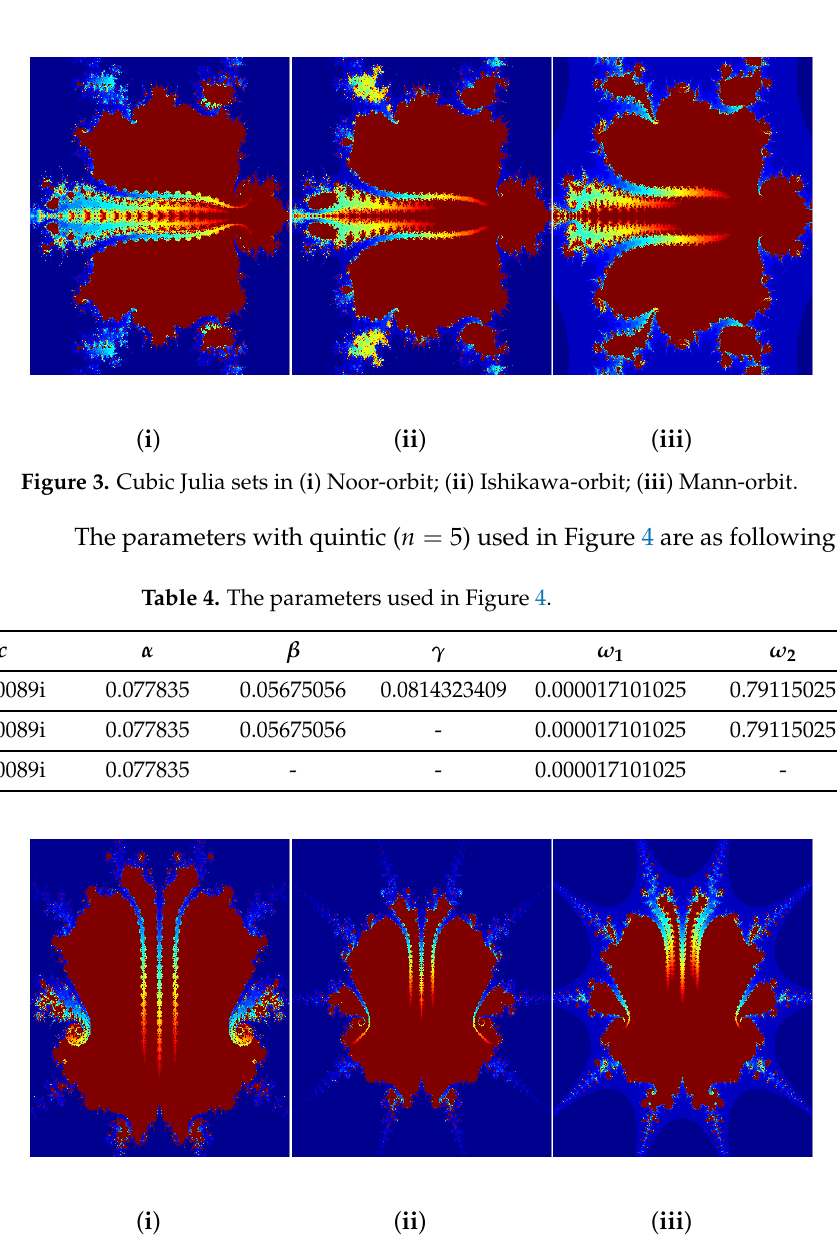
Figure 4. Quintic Julia sets in ( i ) Noor-orbit; ( ii ) Ishikawa-orbit; ( iii ) Mann-orbit. The parameters used in Figures 5–7 with septic ( n = 7) are as following in Table 5: Table 5. The parameters used in Figures